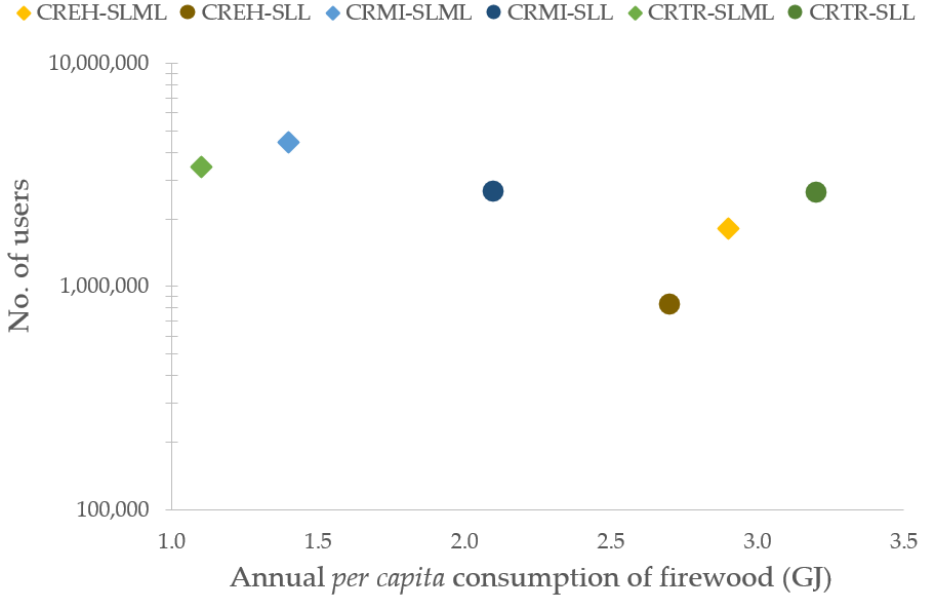
Figure 9. Annual per capita consumption of firewood and number of MSU in socioeconomic levels, by climate region. EH, extreme heat; MI, mild; TR, tropical; ML, moderately low; L, ow. Source: Own elaboration.